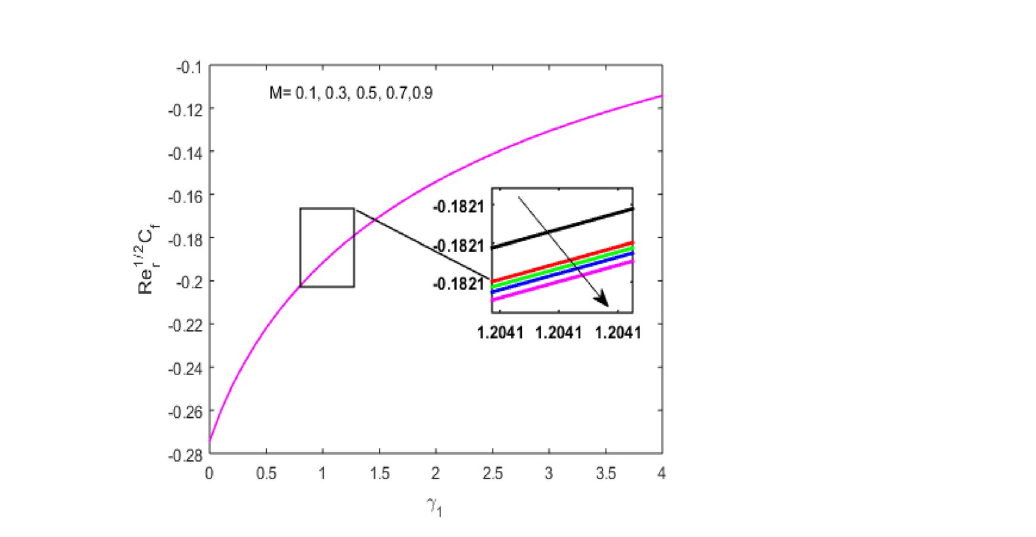
Figure 6. ( Re r ) 1 / 2 C f versus γ 1 for varying M .